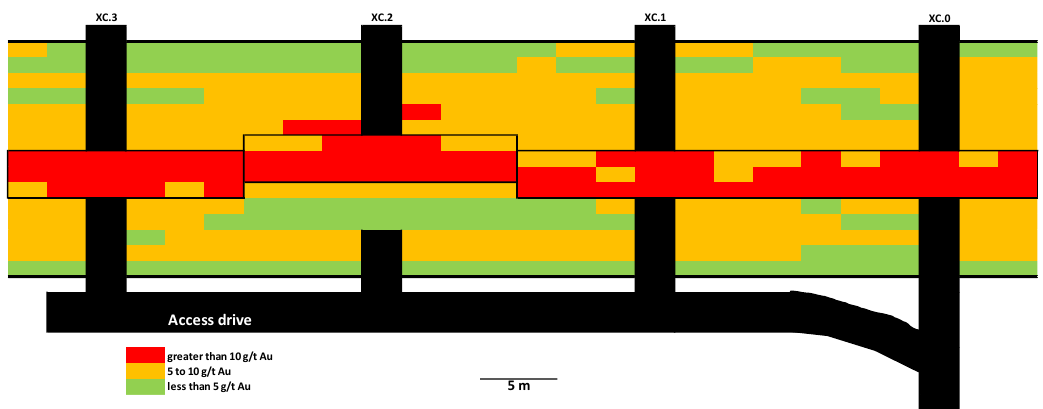
Figure 8. High-resolution grade-control model by CS showing HGZ amenable to narrow vein mining. Trial stope focussed on areas defined by black outlines.